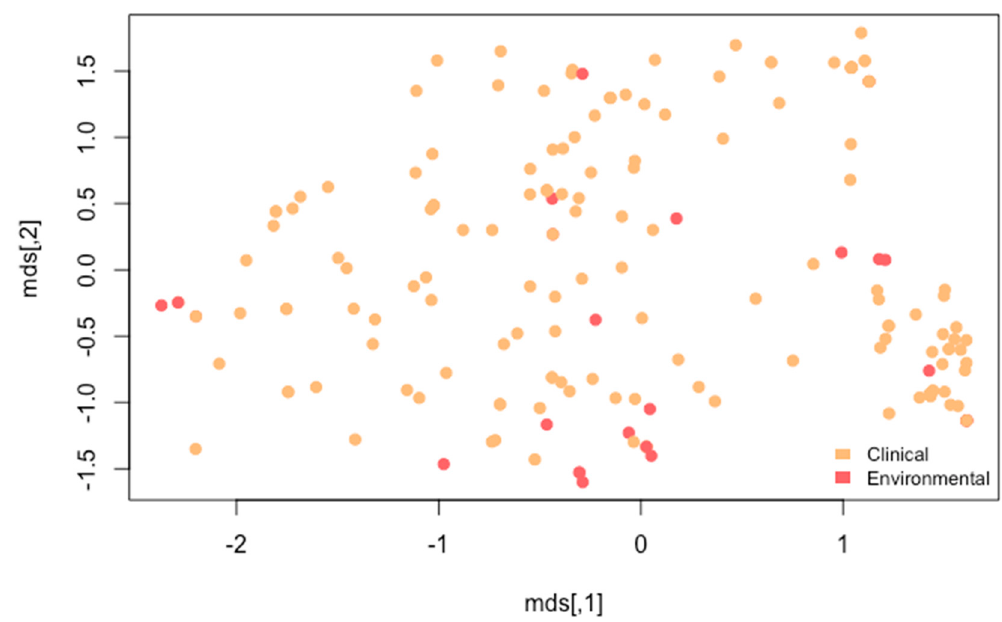
Figure 5. Multidimensional scaling (MDS) plot showing relationships among 196 strains based on the top 65 SNPs that showed associations with AMB susceptibilities. Each filled circle represents a strain. Circles in red were of environmental origins, while those in brown were from clinical